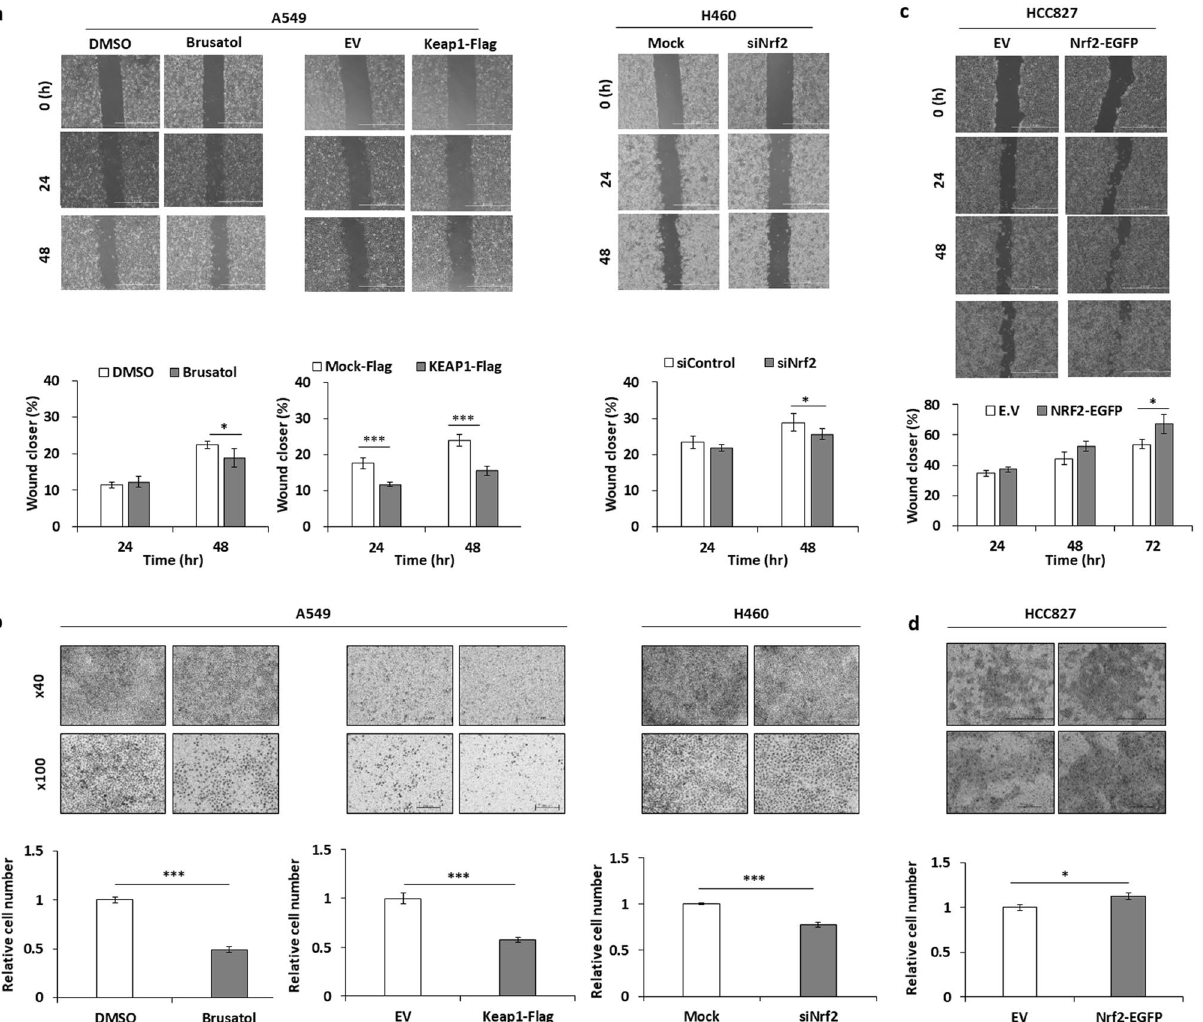
Figure 2. Nrf2 regulates cell motility. Nrf2 expressed was suppressed in A549 or H460 cells following treatment with brusatol (10 nM) or transfection of Keap1-Flag or siNrf2. ( a , c ) Horizontal migration of these cells was compared with that of the control cells using wound healing assay for the indicated time points. ( b , d ) Nrf2 was overexpressed by transfecting Nrf2-EGFP into the HCC827 cells. Vertical migration was detected by transwell assay after brusatol treatment or transfection for 24 h. The degree of migration was quantified by calculating the area of migrated cells using the image processing software, Image J (Ver. 1/52n, NIH, Bethesda, MD,